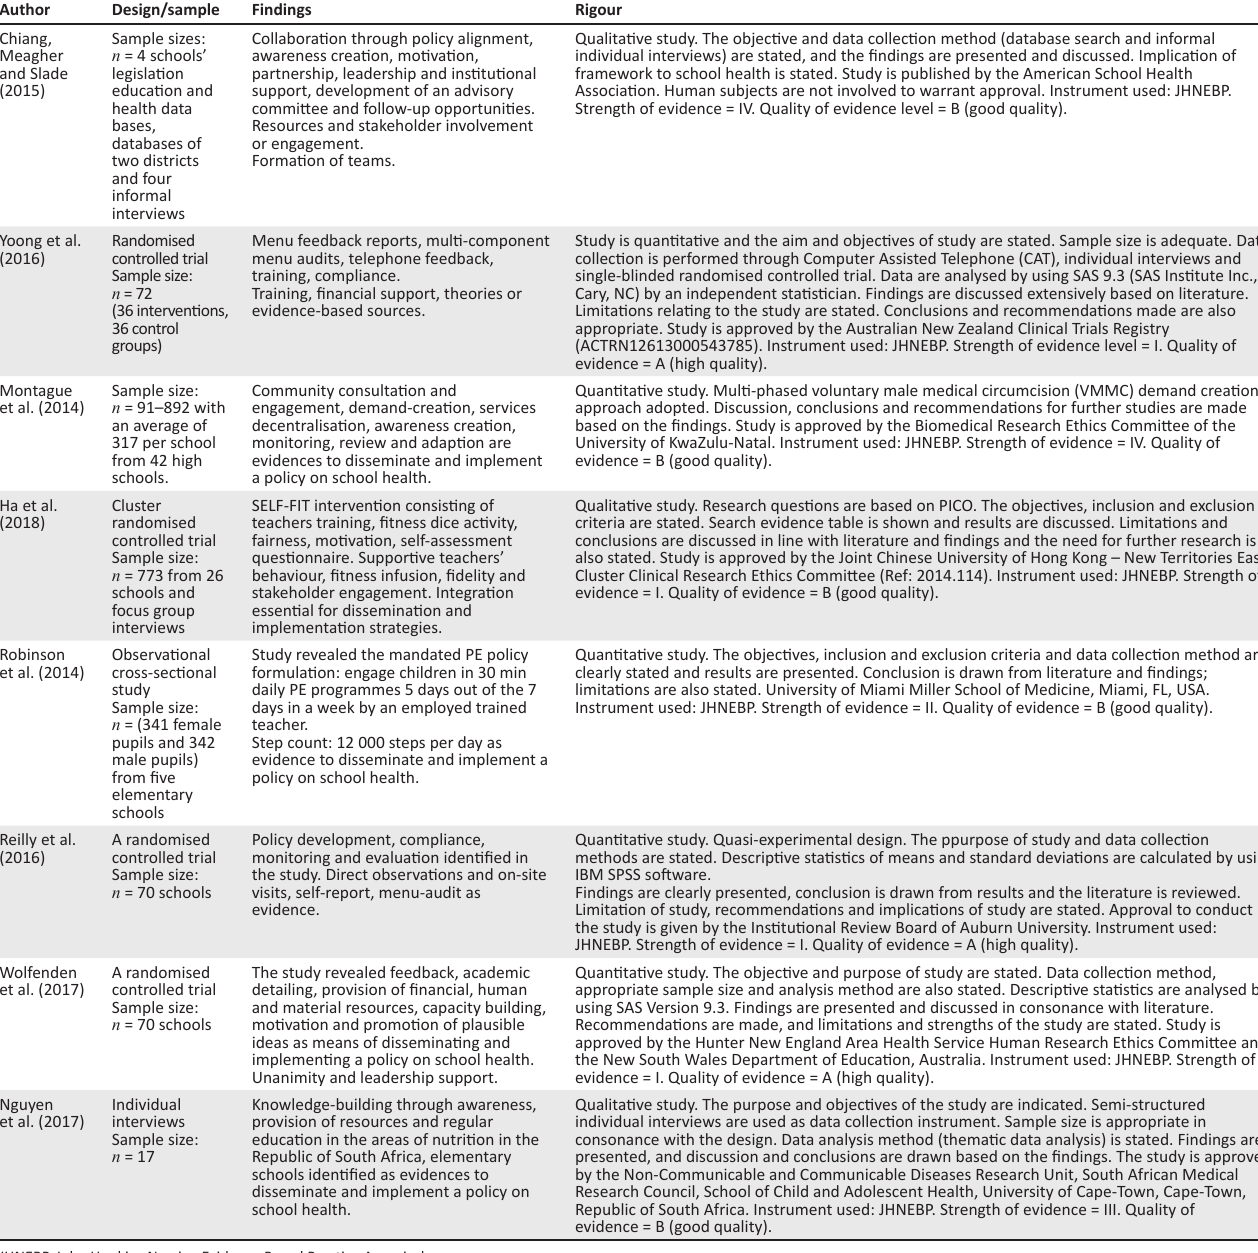
TABLE 2(Continues...): Evidence table of studies included for